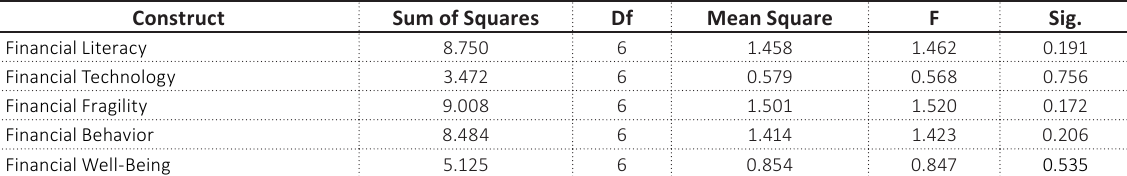
Table 13. One-way ANOVA for each factor across father’s education